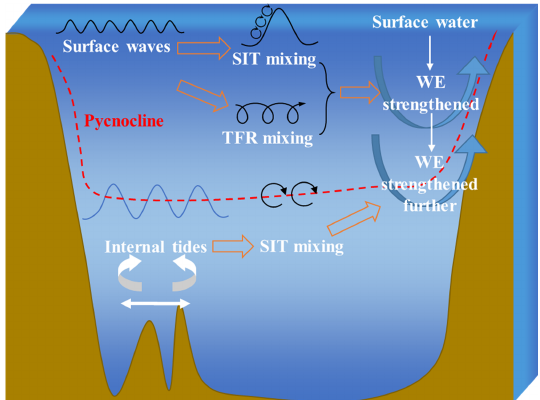
Figure 14. Sketch of the enhancing processes of the vertical mixing induced by three different mechanisms, including NBSW-generated turbulent mixing, WTFR-induced mixing and IT-generated turbu- lent mixing. SIT and TFR mixing represent the shear-induced tur- bulent and transport flux residue mixing, respectively. WE means the water